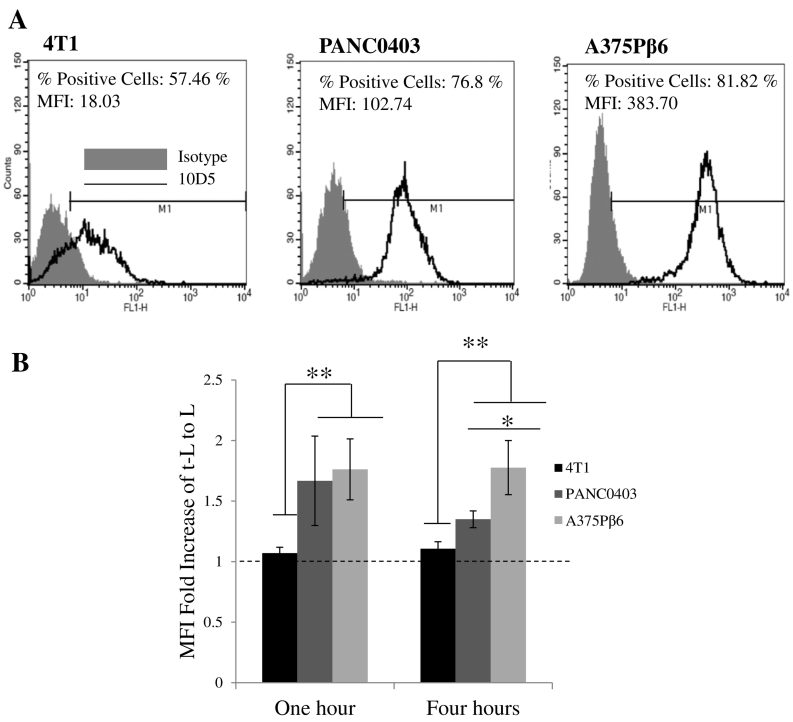
The effect of the extent of expression of αvβ6 integrin receptor on the uptake of t-L. (A) Representative images of cell lines incubated with the antibody 10D5 (specific to αvβ6) or an isotype control. Cells were analysed for αvβ6 integrin receptor expression using flow cytometry and FL-1 detector. In a comparison of the αvβ6 expression of different cell lines using the % positive cells gated in M1 or the MFI, the 4T1 cancer cell line showed the lowest receptor expression, while A375Pβ6 has the highest expression both in terms of % of positive cells and the number of receptors per cell. (B) Comparison of the MFI fold increase of fluorescently labelled t-L to L. Cells were treated with 32.5 μM L or t-L for 1 or 4 h. With increasing expression of αvβ6, the uptake of t-L in relation to L further increases. This is a further indication of the specificity of the t-L to the αvβ6 integrin receptor. Values are expressed as mean ± SD (n = 3). *p < 0.05, **p < 0.01 (ANOVA).